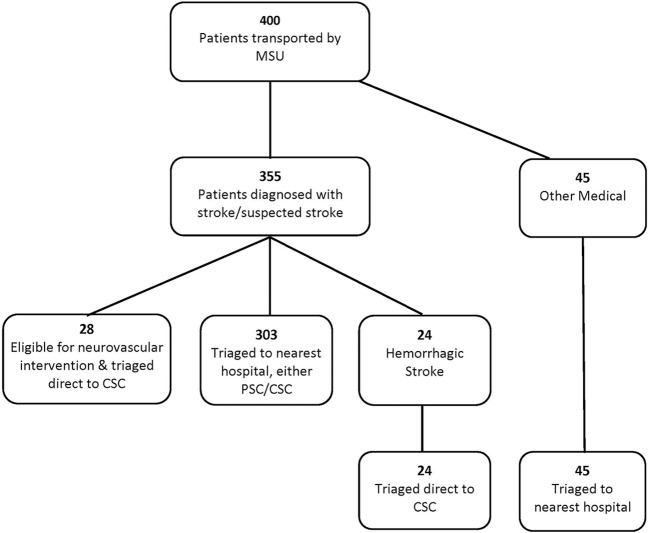
Patient flow diagram.